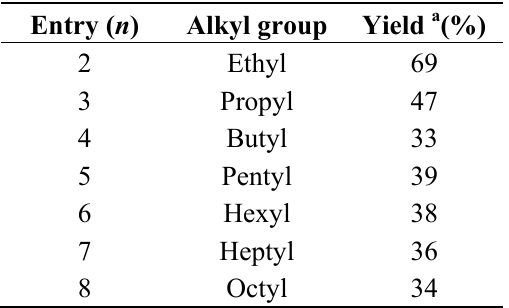
Table 1. Yields of 2-(4'-alkoxybiphen-4-yl)-5-cyanopyridines ( nO- PPPyCN, n = 2–8).